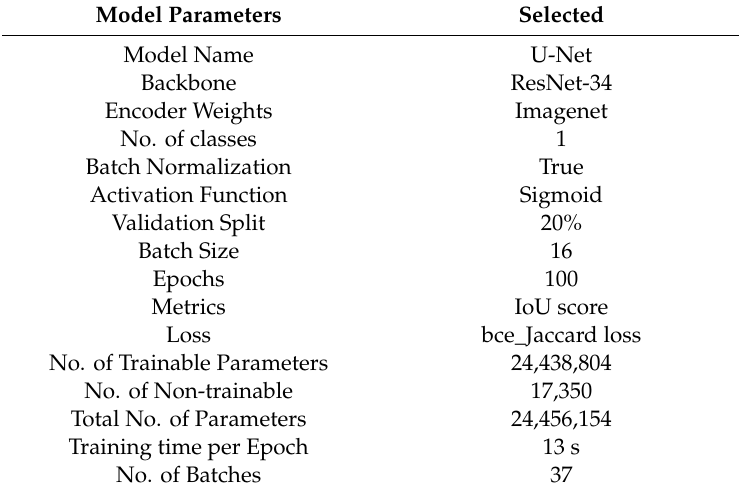
Figure 6. Training and validation results. ( a ) Intersection over union (IoU) score vs. Epochs, ( b ) F1 score vs. Epochs, ( c ) bce_jaccard_loss vs. Epochs, ( d ) learning rate vs. Epochs. Table 1. Model